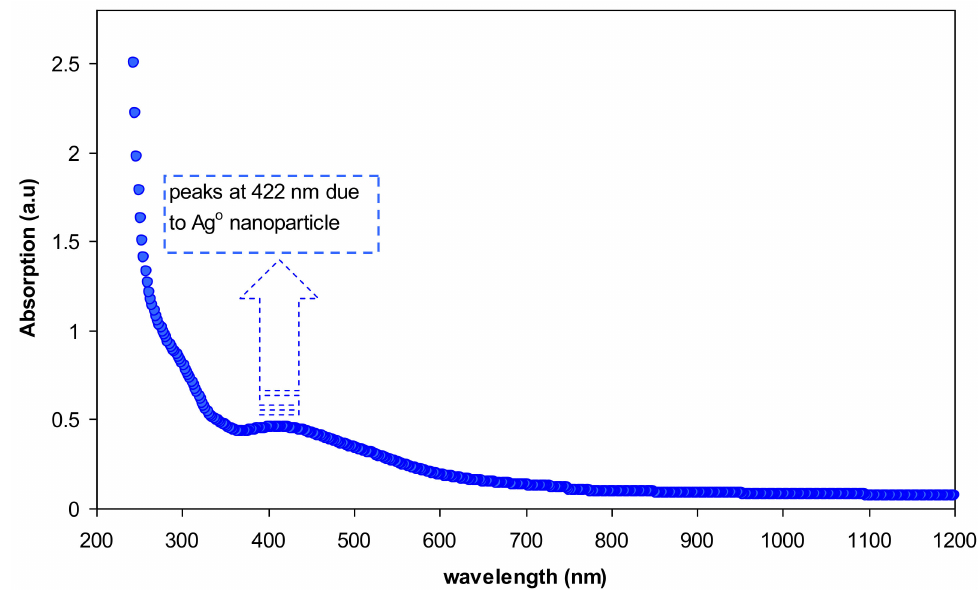
Figure 9. Absorption spectra of chitosan:AgNt complex